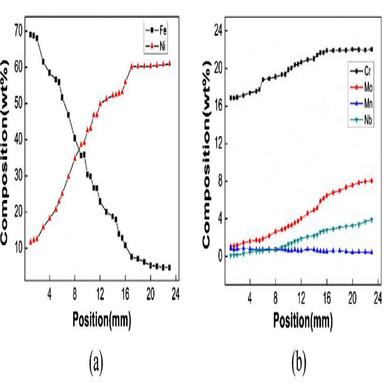
The composition distribution of FGM (a and b).